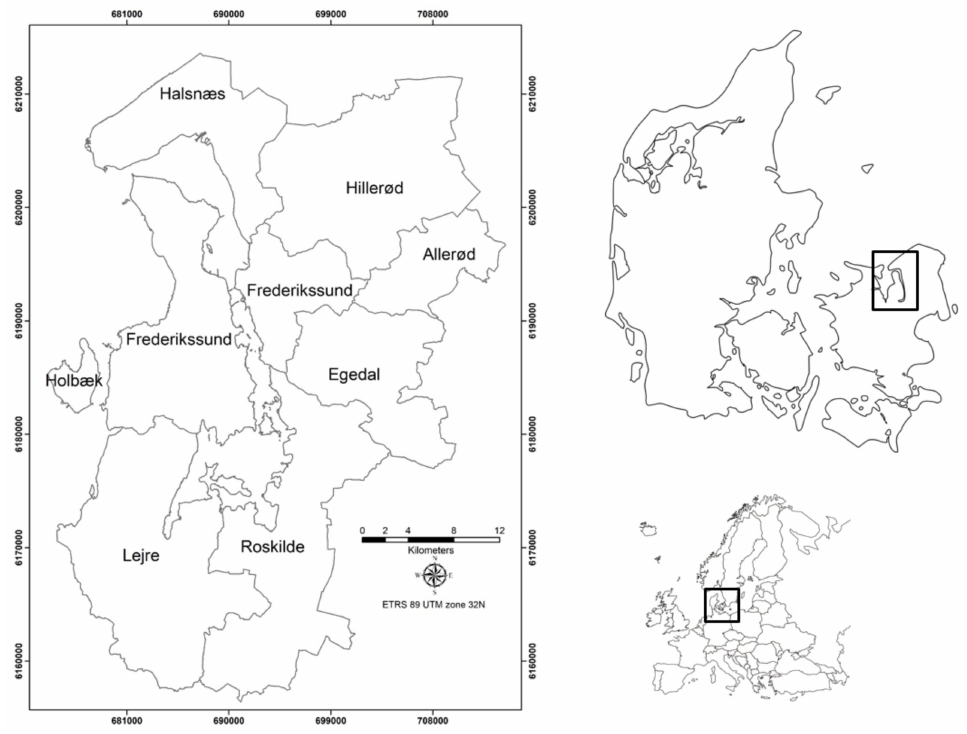
Figure 1. Location of the study